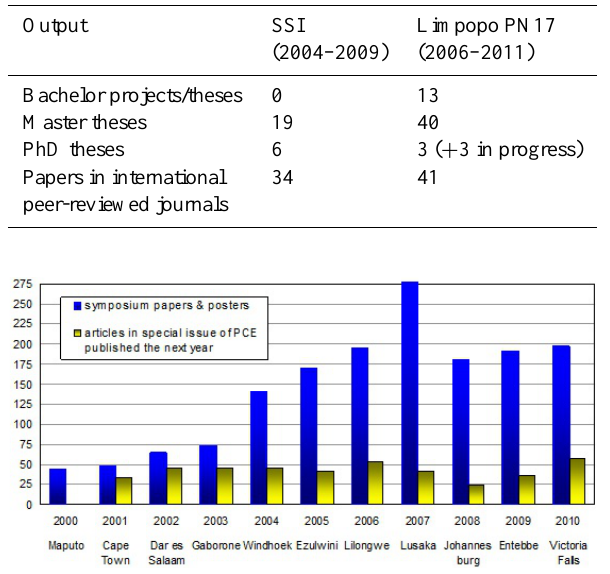
Fig. 5. Symposium papers and posters presented at the annual Wa- terNet Symposia, and the number of papers published in the annual special issue of Physics and Chemistry of the Earth .